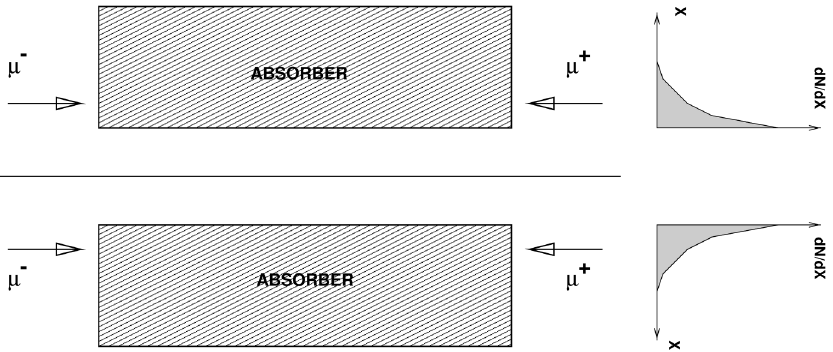
FIG. 52. Scraping muon beam halo with a 5 m steel